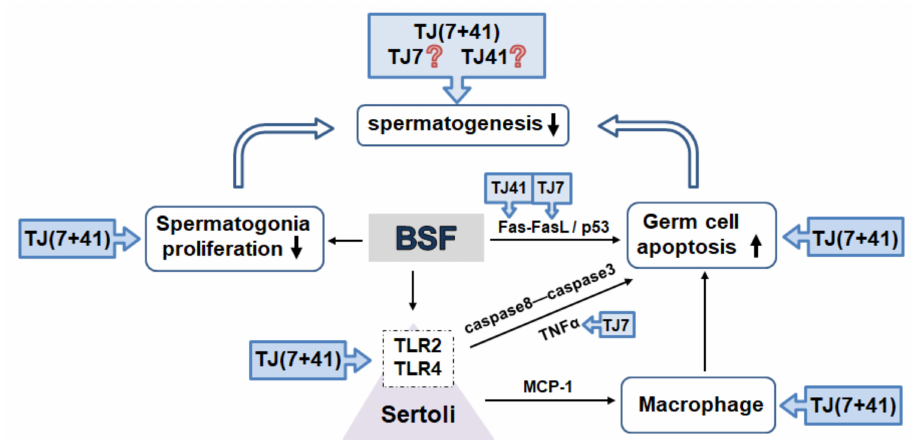
Figure 7. The traditional Japanese medicine modulated testicular immune-related inflammation. BSF-treatment disrupted spermatogenesis by decreased ( ↓ ) proliferation and increased ( ↑ ) apoptosis in the germ cells. Activated TLR2 and TLR4 expression in the Sertoli cells (bounded by dotted frames) induced extensive apoptosis in the germ